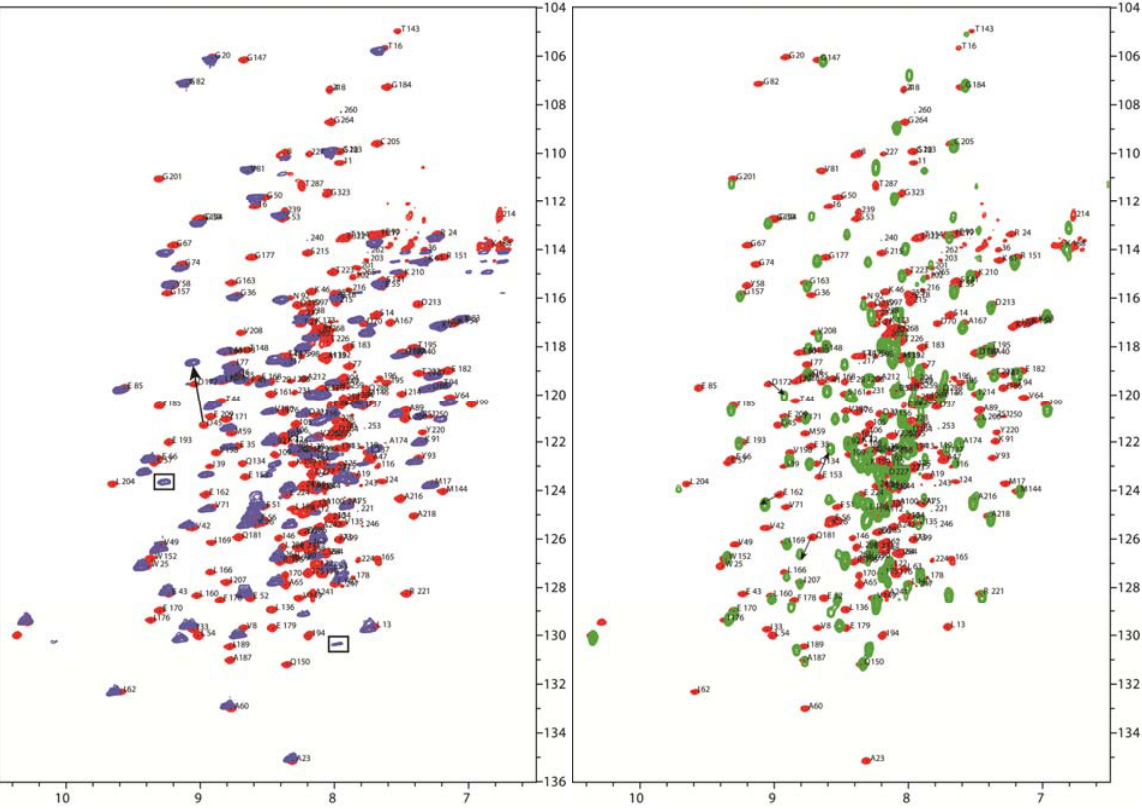
Figure 8. 15 N- 1 HHSQC-TROSY spectra of L1L2S (red peaks) overlaid with L1 (blue peaks) ( Left ) and L2S (green peaks) ( Right ). Two residues from the L1 domain which disappeared in the L1L2S construct are indicated with a box. Residues which show large chemical shift change are indicated with arrows. Assigned peaks are indicated with one letter amino acid code and residue